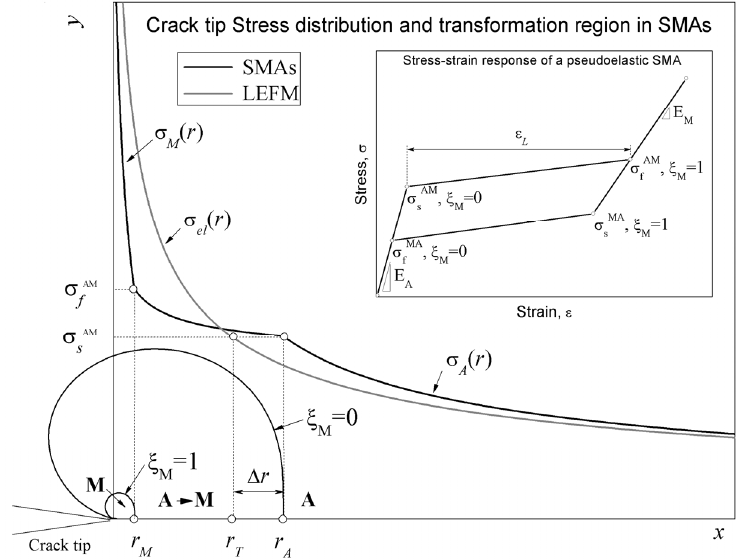
Figure 1: Schematic depiction of the crack-tip stress distribution and transformation region in pseudoelastic NiTi SMAs.